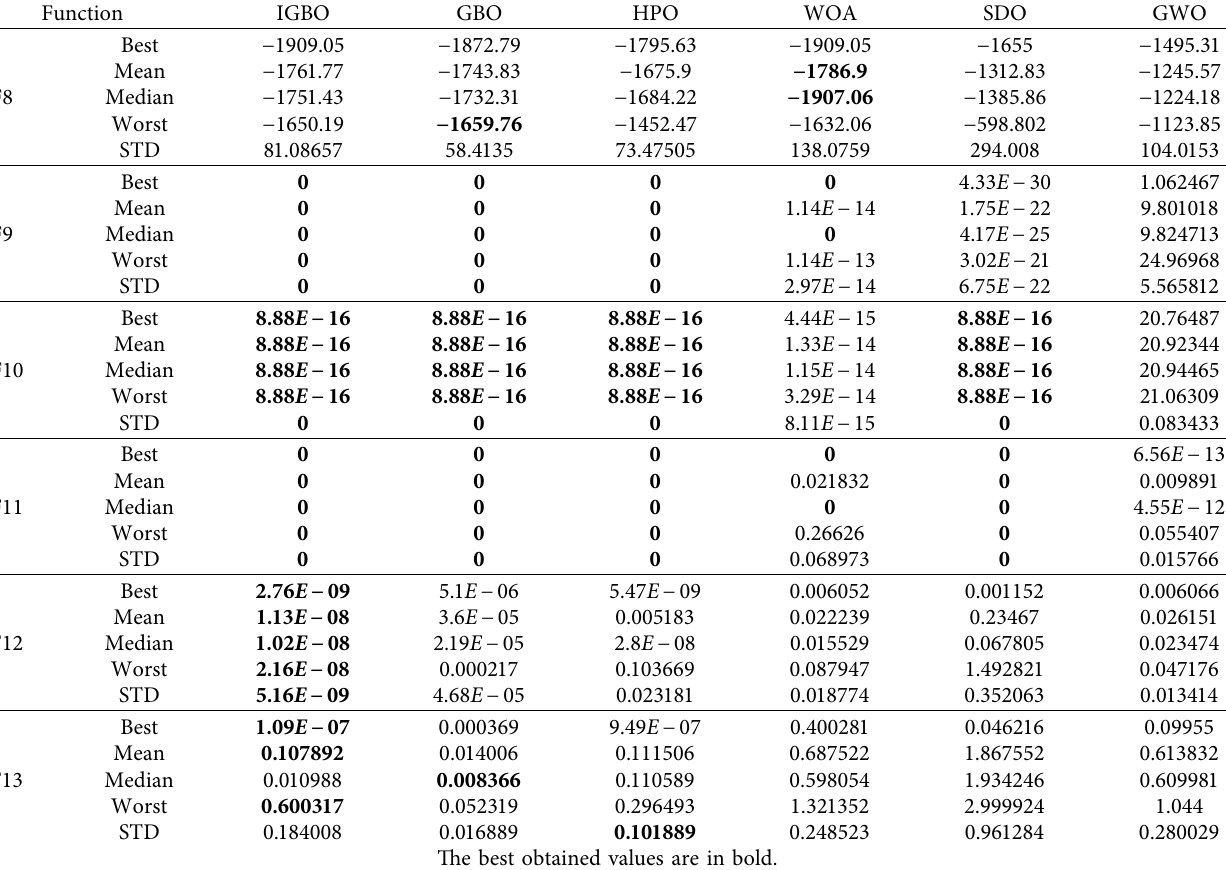
Table 2: Results of multimodal benchmark